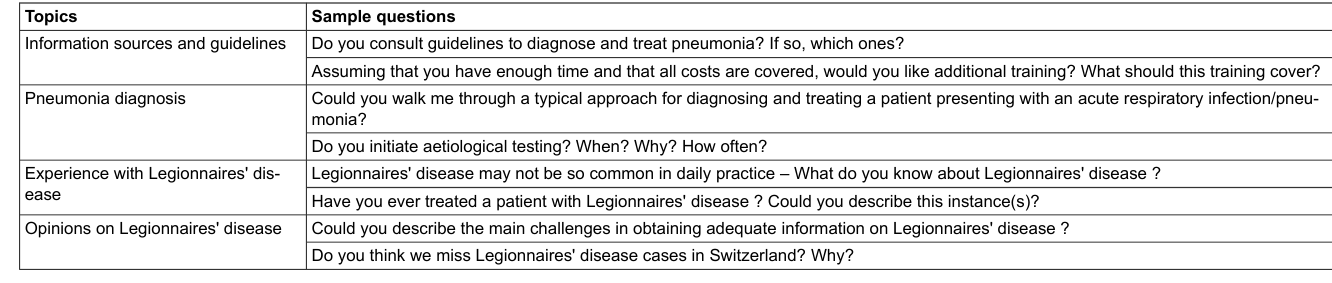
Table 1: Overview of the semi-structured interview guide for in-depth interviews on pneumonia and Legionnaires' disease with physicians in Switzerland.